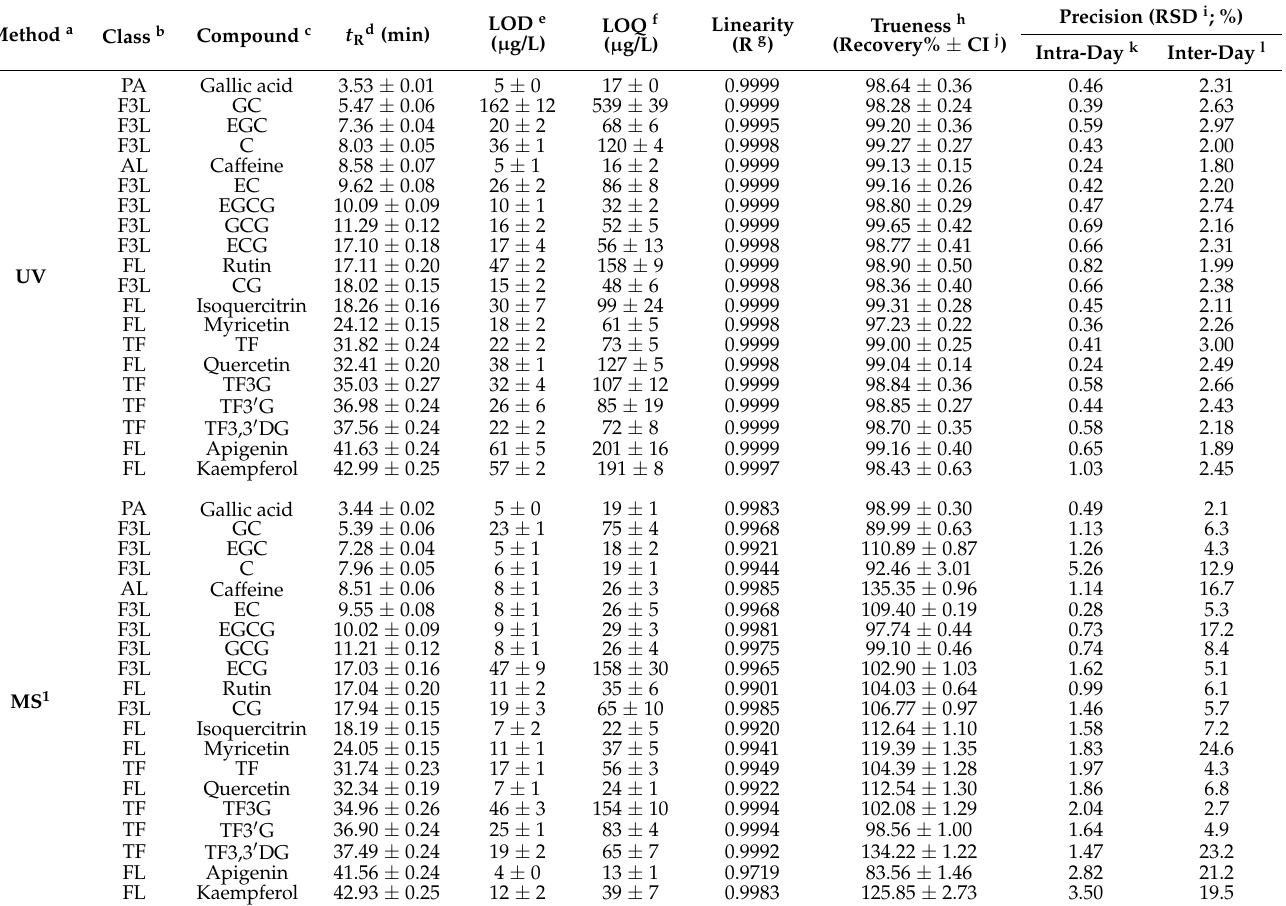
Table 1. Method validation of UV detection versus mass